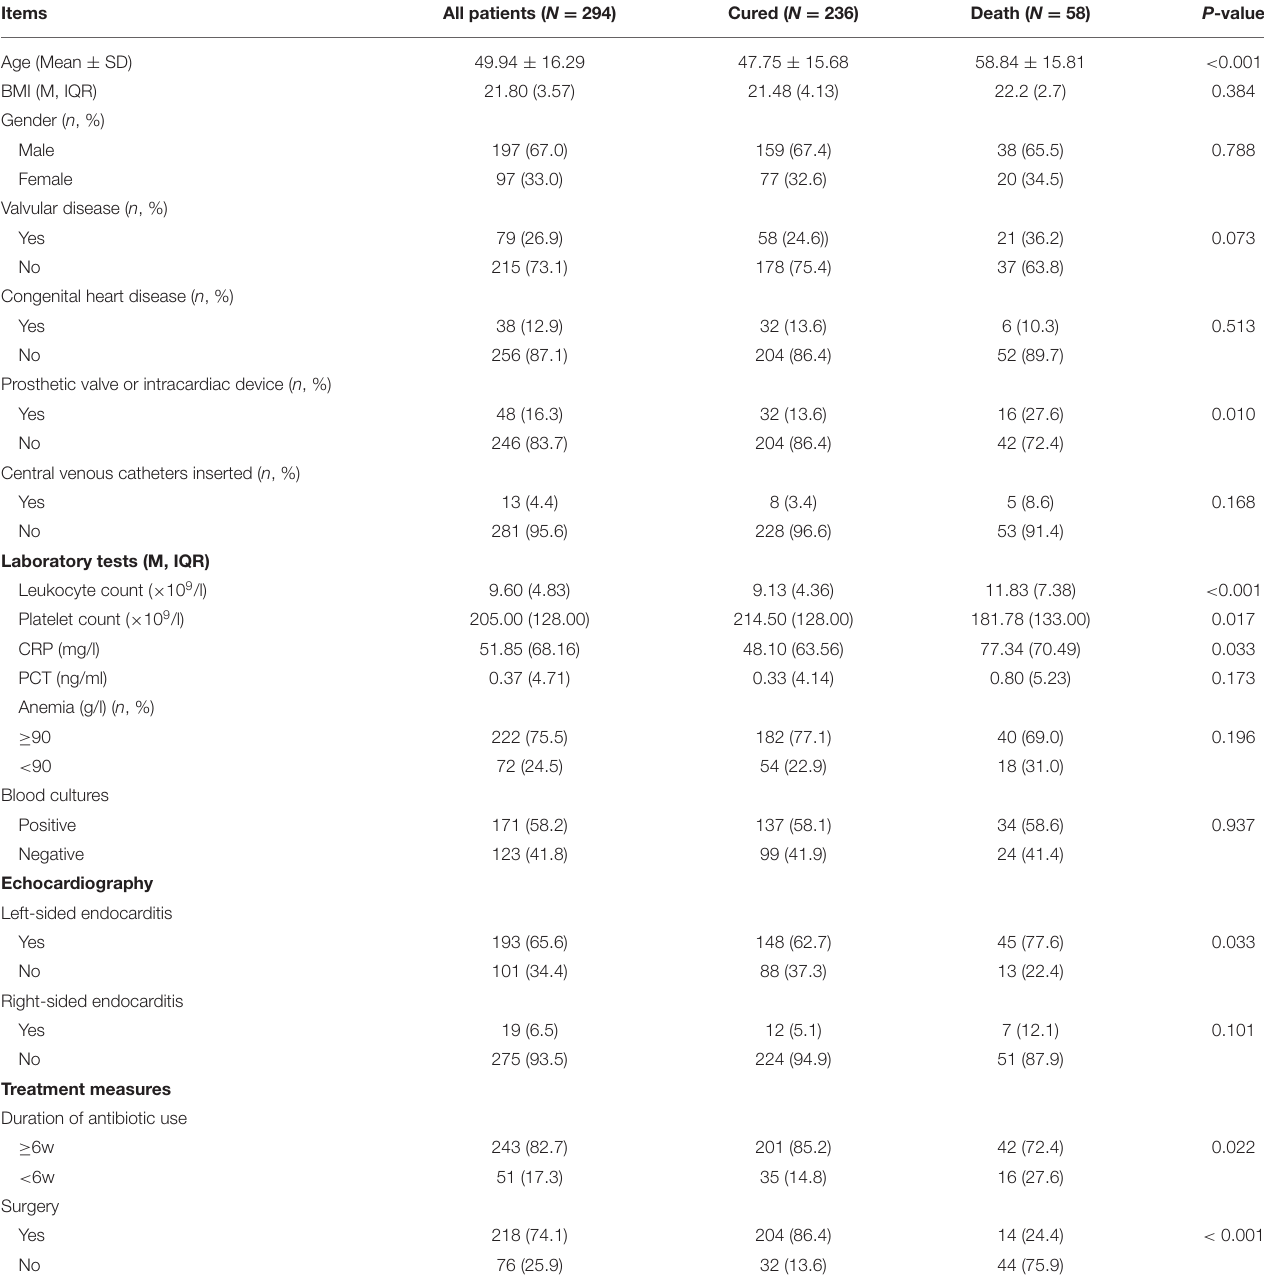
TABLE 2 | Comparison of clinical characteristics and laboratory tests of the two groups.